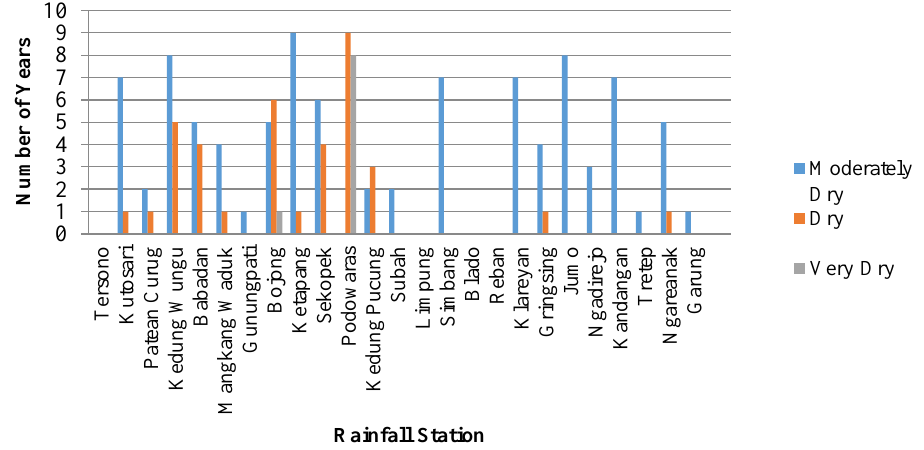
Figure 3. Number of rainfall stations experiencing moderately dry or worse conditions.